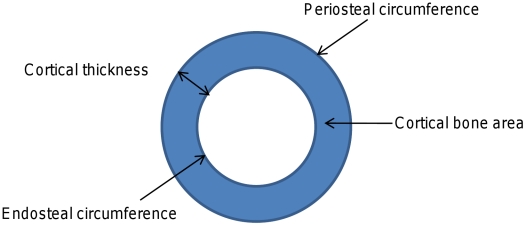
Cartoon depicting different cortical dimensions derived from tibial pQCT scans.Cortical bone mass is derived from the product of cortical bone area and cortical density.